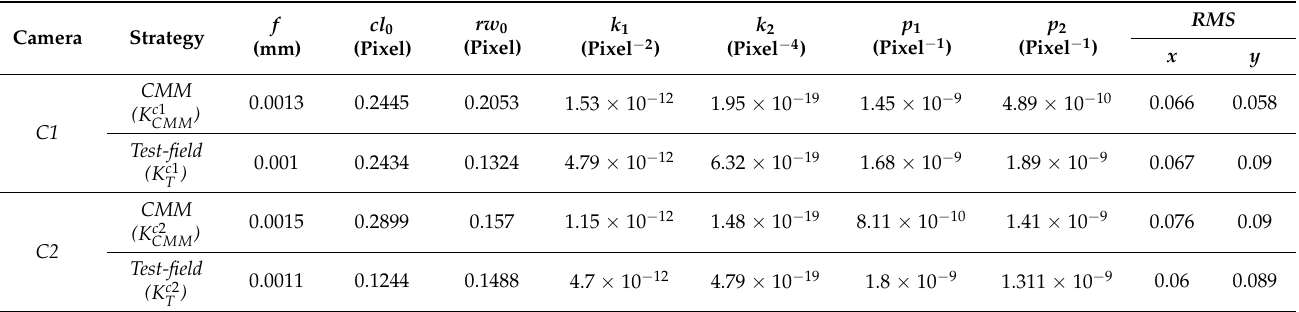
Table 1. The precision results (1-sigma) of the intrinsic parameters of each C camera for pyramid virtual grid and test-field